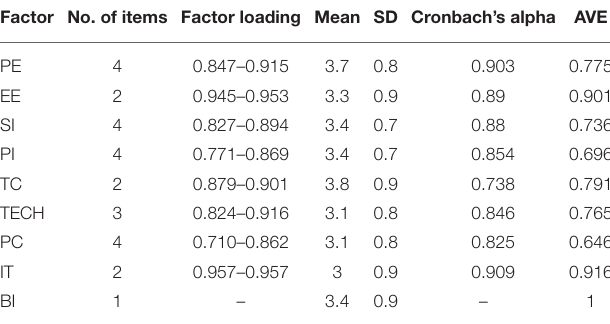
TABLE 2 | Reliability and validity of the measure ( n = 211).